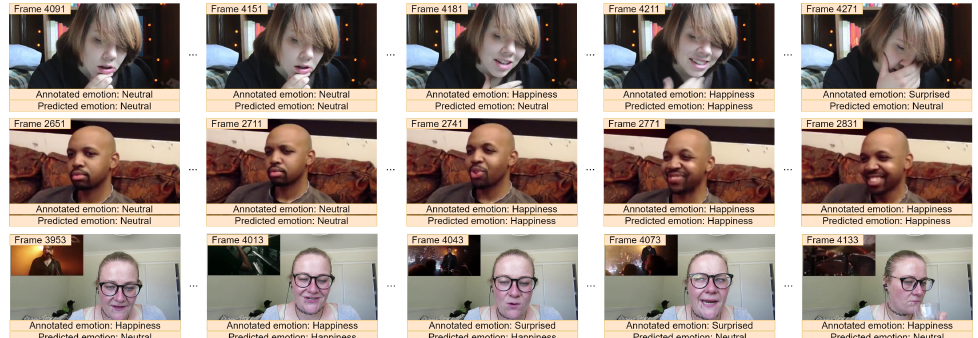
Figure 9. Example frames in the temporal vicinity of emotion change points in video clips with the corresponding ground truth and predicted emotion classes.